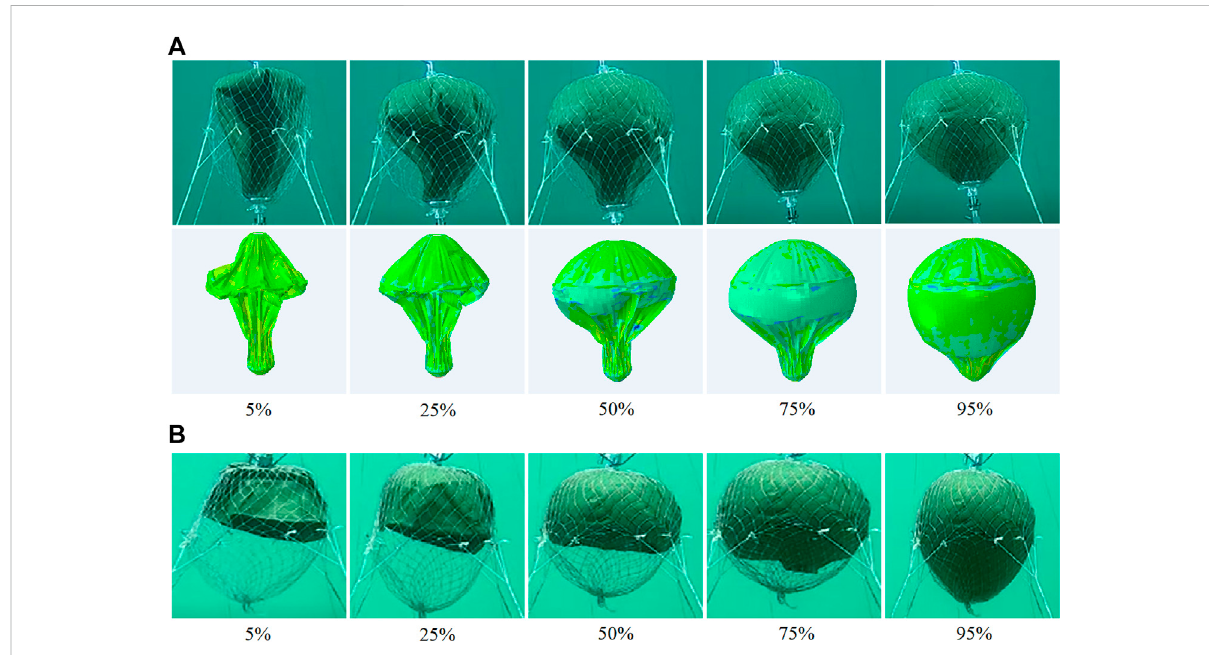
FIGURE 8 Deformedshapeofthetankatdifferentvolumes: (A) witharigidconnectionbetweenthetopandbottom fl anges; (B) withoutrigidconnection.